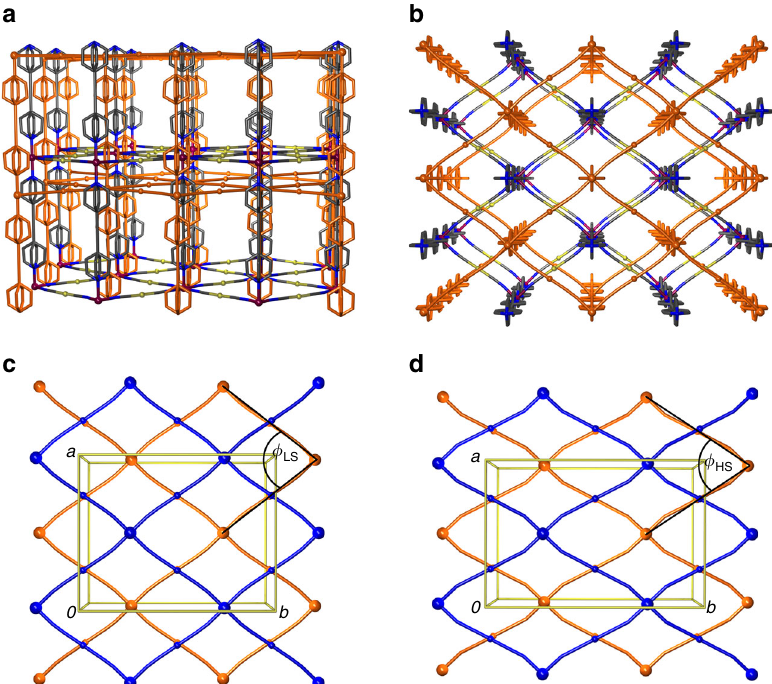
Fig. 1 Single crystal structure of [Fe]. a at 190 K viewed along the a -axis, and b , the c -axis directions. The lattice conformation of the {Fe(Au(CN) 2 ) 2 } sheets in the ab -plane is shown for comparison at 190 K c , and 240 K d . Note the relative LS – HS change in the unit cell dimensions: Δ a = − 6.8%; Δ b = + 10.2%. Au ··· Fe ··· Au angles: ϕ = 76.85°; ϕ = 67.77°. Fe and Au centres are represented by larger and smaller spheres respectively and the LS HS interpenetrating nets are shaded blue and orange . Hydrogen atoms and disordered solvent are omitted for